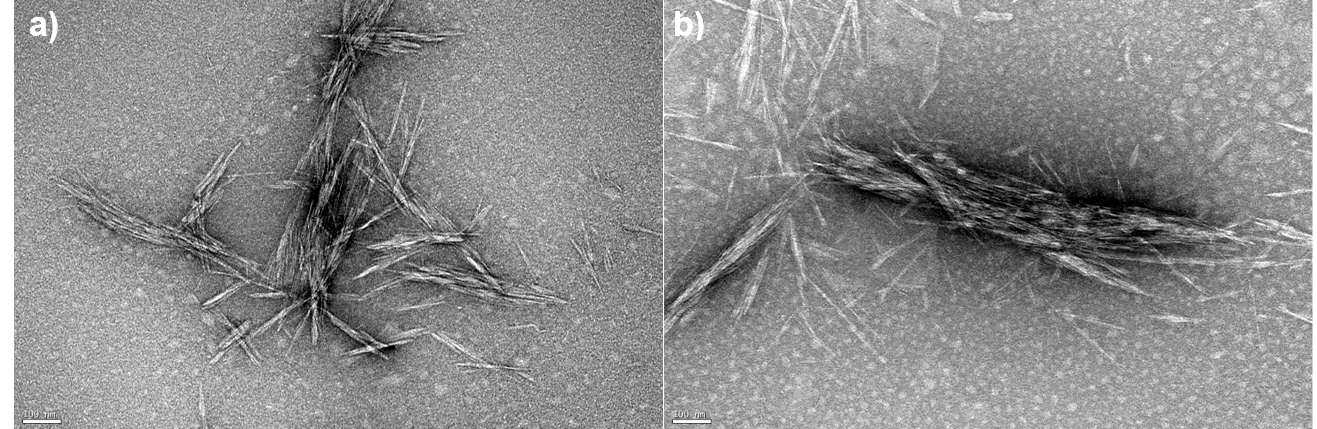
Figure 9. Transmission electron microscopy images of ( a ) free cellulose nanocrystals modified with cetyltrimethylammonium bromide (CNC-CTAB) and ( b ) CNC-CTAB encapsulating curcumin (100,000×, 120 kV, scale bar equals 100 nm).